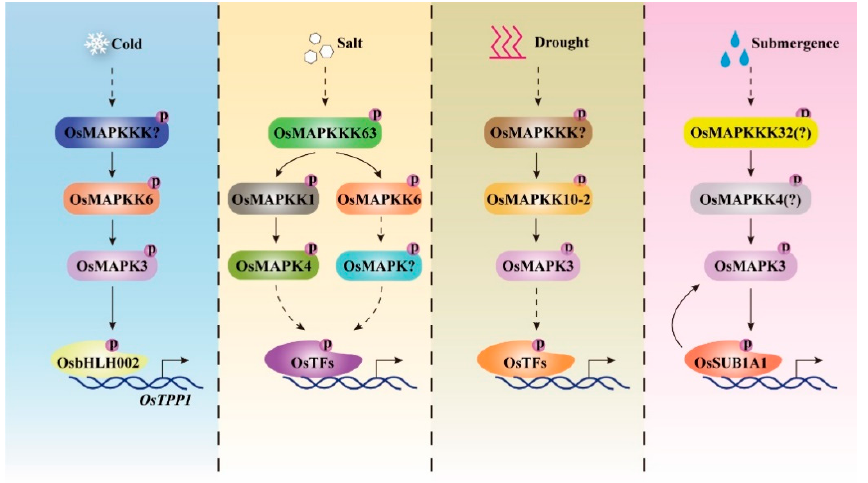
Figure 3. Rice MAPK cascades are activated by different abiotic stress signals and confer tolerance to diverse abiotic stress in rice. A variety of abiotic stress, such as cold, salt, drought, and submergence could activate diverse rice MAPK cascades, which play critical roles in triggering rice resistance to these stresses [16,25–28,34–36,67,68]. OsMAPKKK63-OsMAPKK1-OsMAPK4 is the only known cascade conferring salt tolerance, while its downstream substrates have not been identified.